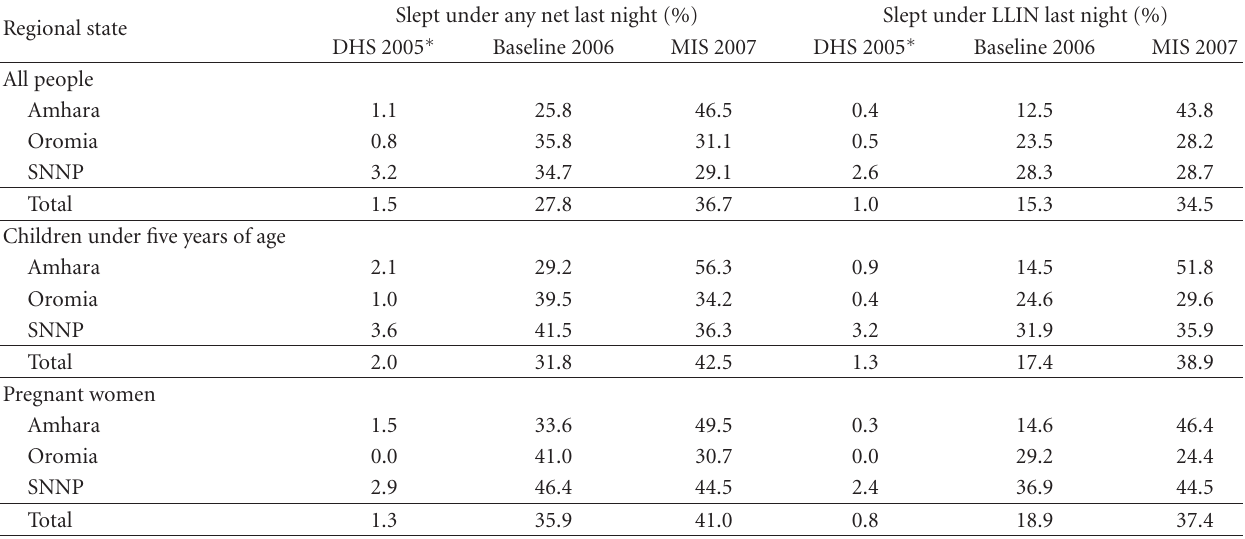
Table 2: Proportion of people who reported sleeping under a net last night in all sampled households in malarious areas of three regional states.